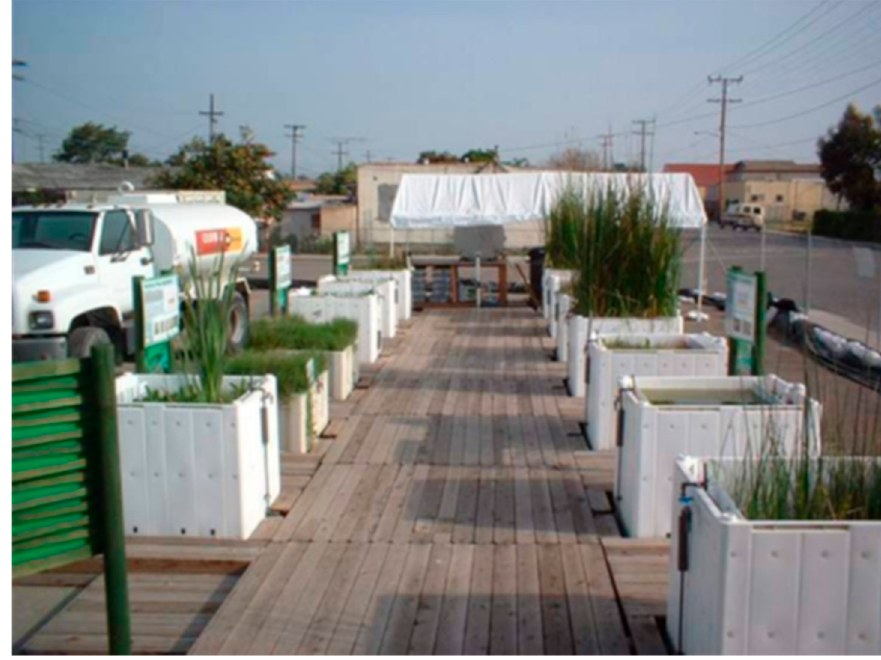
Figure 5. Con fi guration of Oxnard membrane concentrate Pilot Study 1. Figure 5. Configuration of Oxnard membrane concentrate Pilot Study